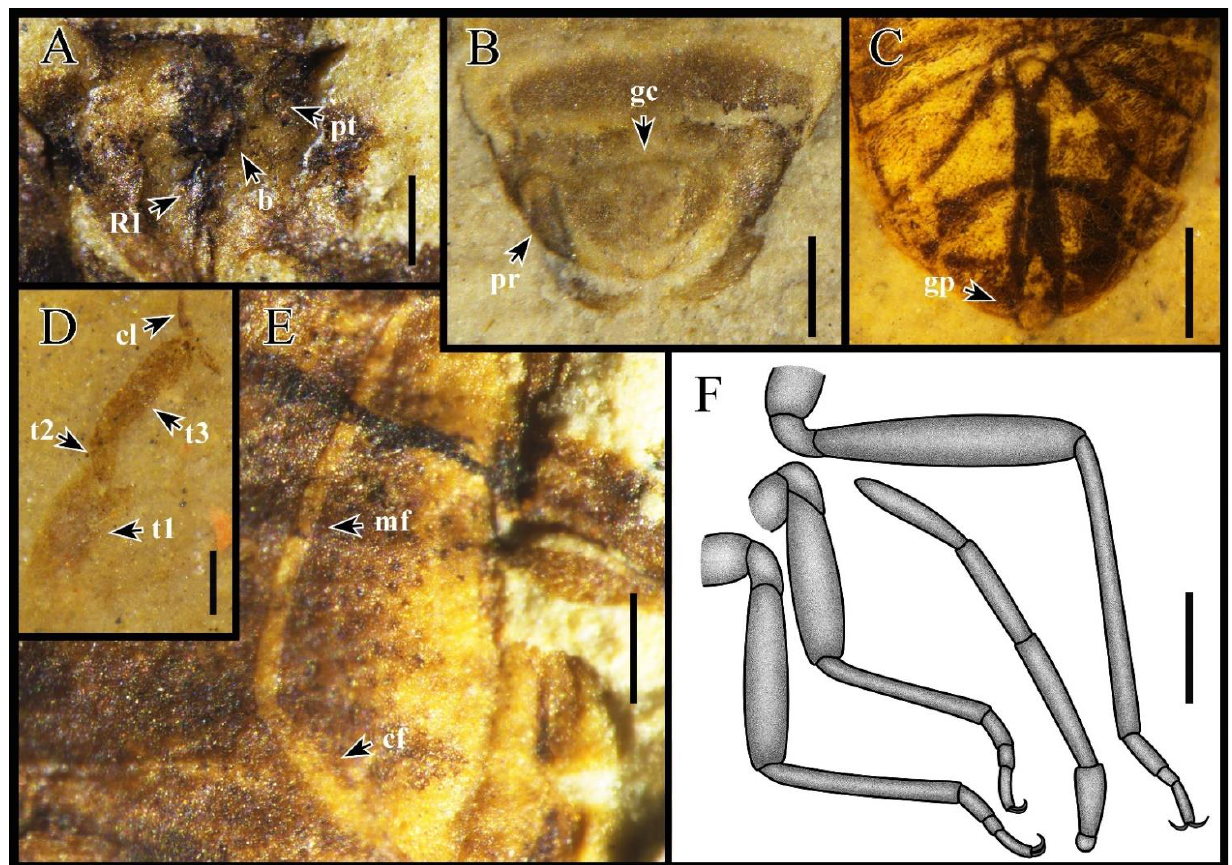
Figure 2. Varicapitatus sinuolatus gen. et sp. nov. with morphological details. ( A ) Head, paratype, female, CNU-HET-LB2022006. ( B ) Dorsal view of male genitalia, holotype, male, CNU-HET-LB2022003. ( C ) Ventral view of female genitalia, paratype, female, CNU-HET-LB2022007. ( D ) Tarsal, paratype, female, CNU-HET-LB2022008. ( E ) Forewing, paratype, female, CNU-HET-LB2022004. ( F ) Line drawing of legs and antennae female, CNU-HET-LB2022009; CNU-HET-LB2022006. Abbreviations are as follows: RI, first rostral segment; b, buccula; pt, preocular tubercle; pr, paramere; gc, genital capsule; gp, gonoplac; t1 – 3, the first to third tarsal segment; cl, claw; mf, medial fracture; cf, costal fracture. Scale bars: ( A ) = 0.2 mm; ( B ) = 0.3 mm; ( C , F ) = 0.5 mm; ( D ) = 0.1 mm; ( E ) = 0.2 mm. Varicapitatus gen. nov., Beipiaocoris Yao, Cai and Ren, 2008 and Bellicoris Yao, Cai and